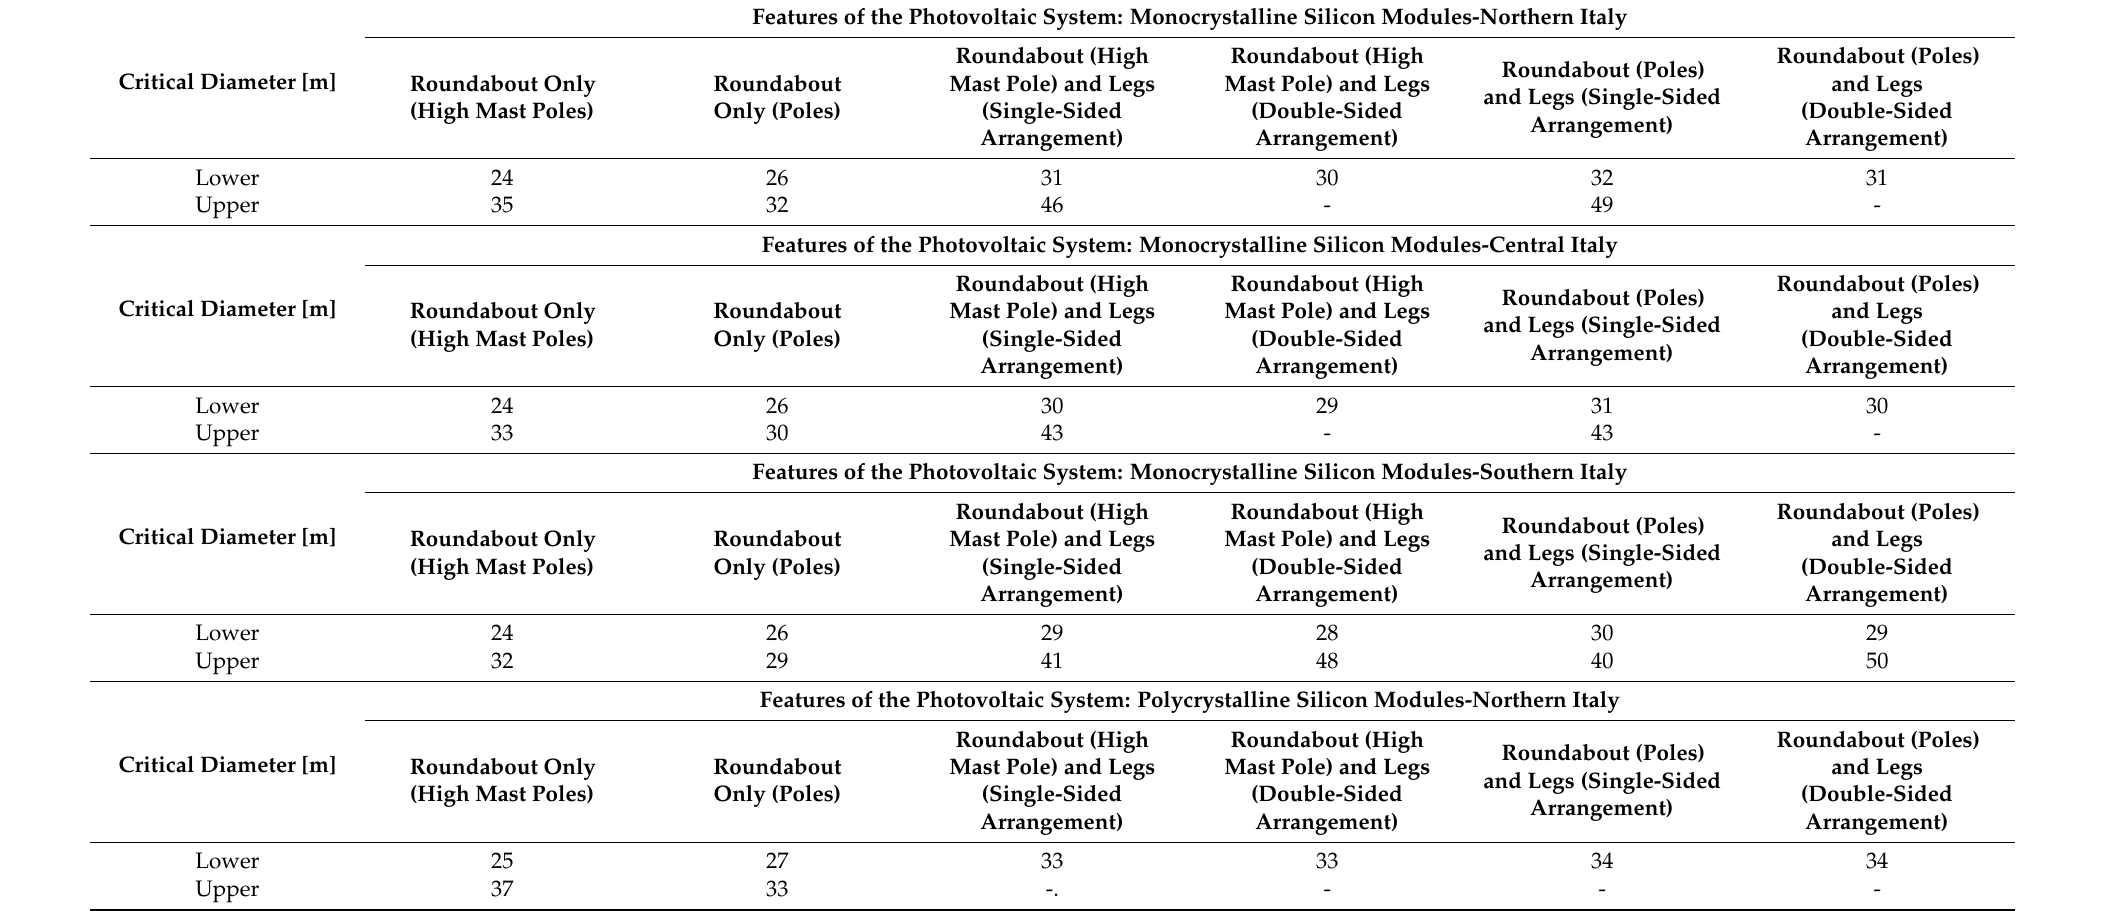
Table 8. Critical diameters (lower and upper) for the different system configurations